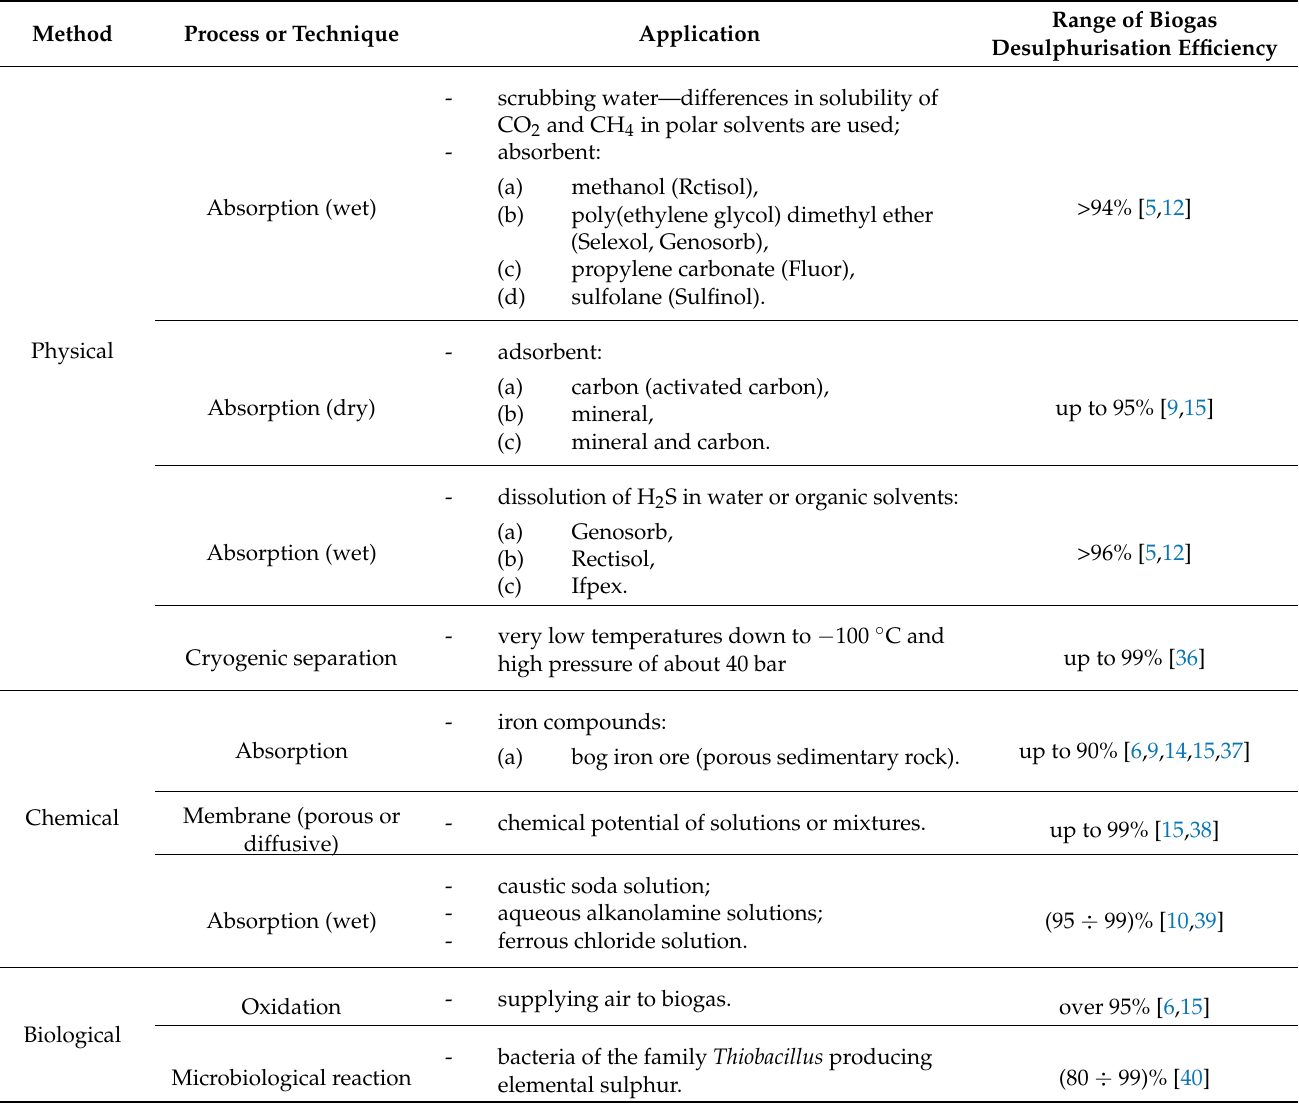
Table 1. Biogas desulphurisation methods [own